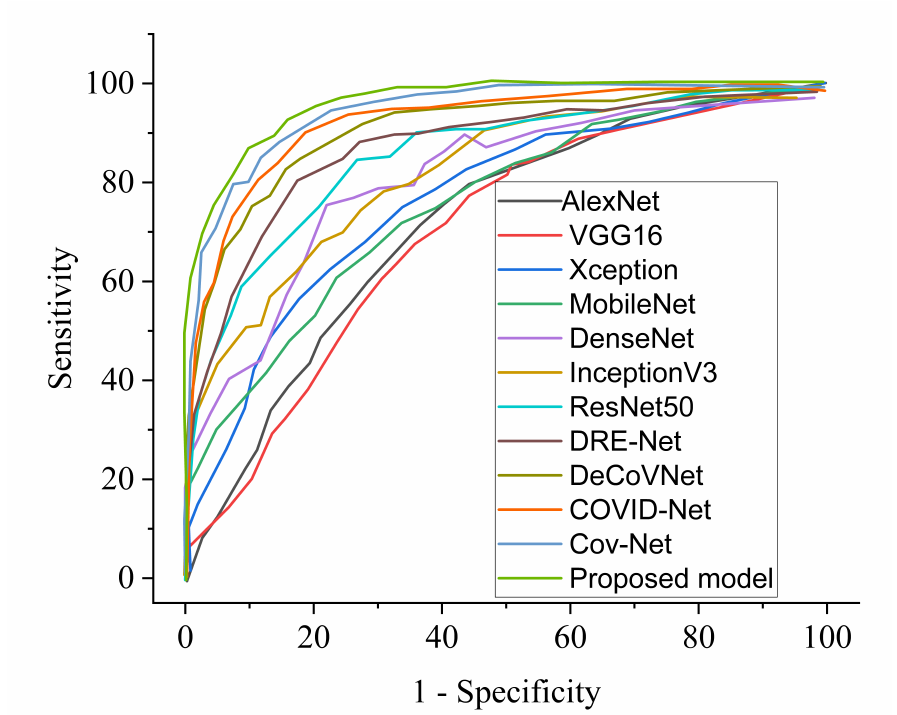
Figure 14. Performance ROC in comparison with our proposed model and other pre-trained models and selected state-of-the-art COVID-19 models for